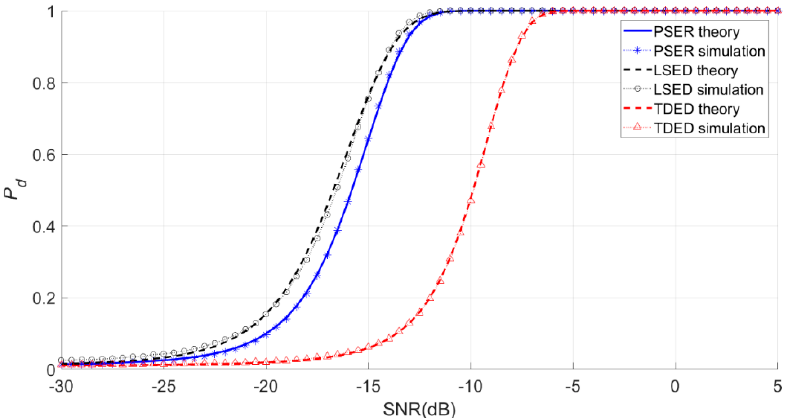
Figure 12. Theoretical and actual detection probabilities obtained by three methods for narrow-band signals when N = 512.